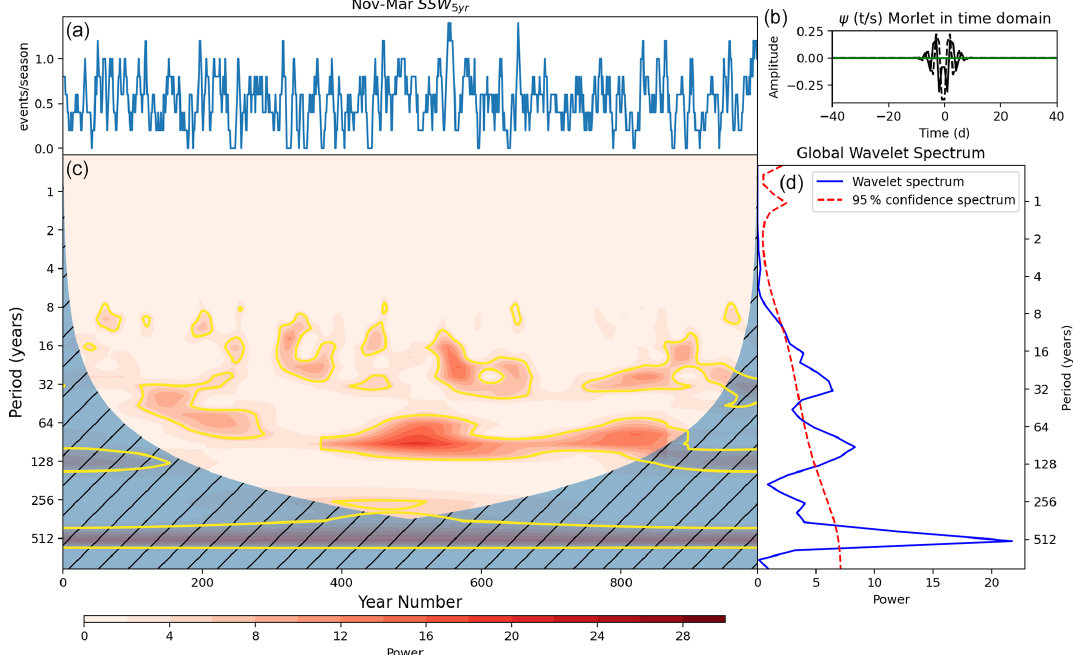
Figure A1. (a) SSW events per November–March season in UKESM smoothed using a 5-year running mean. (c) Wavelet power spectrum of time series in panel (a) . Hatching represents area outside the cone of influence in which edge effects are significant and power should not be considered. Yellow contours represent 95% confidence level assuming mean background AR1 red noise. (b) Morlet wavelet used for the wavelet transform in the time domain. (d) Global power spectrum, the wavelet power averaged over the whole simulation and global 95% confidence spectrum.